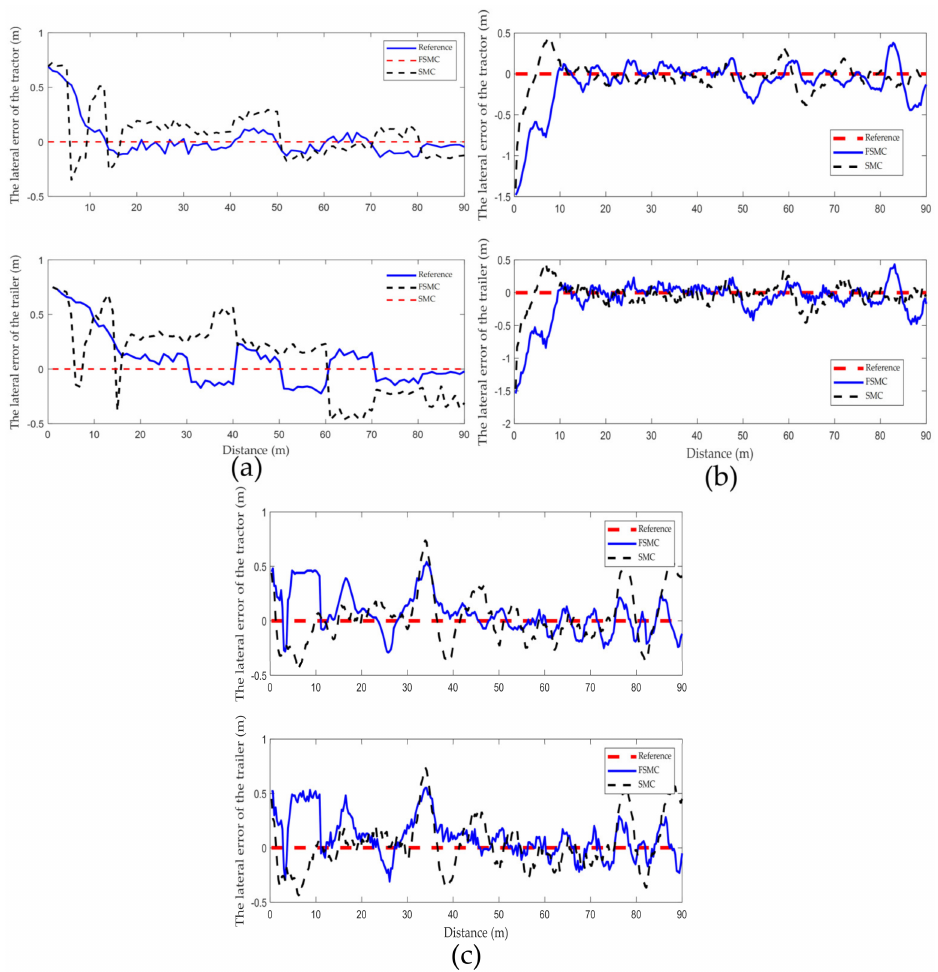
Figure 8. The lateral errors of the tractor and trailer in three tests: ( a ) Test 1; ( b ) Test 1; ( c ) Test